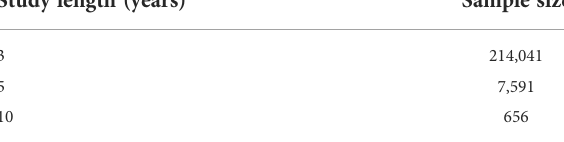
TABLE 3 Estimated sample size required for a clinical study designed to support or refute the results of the Markov modeling. Study length